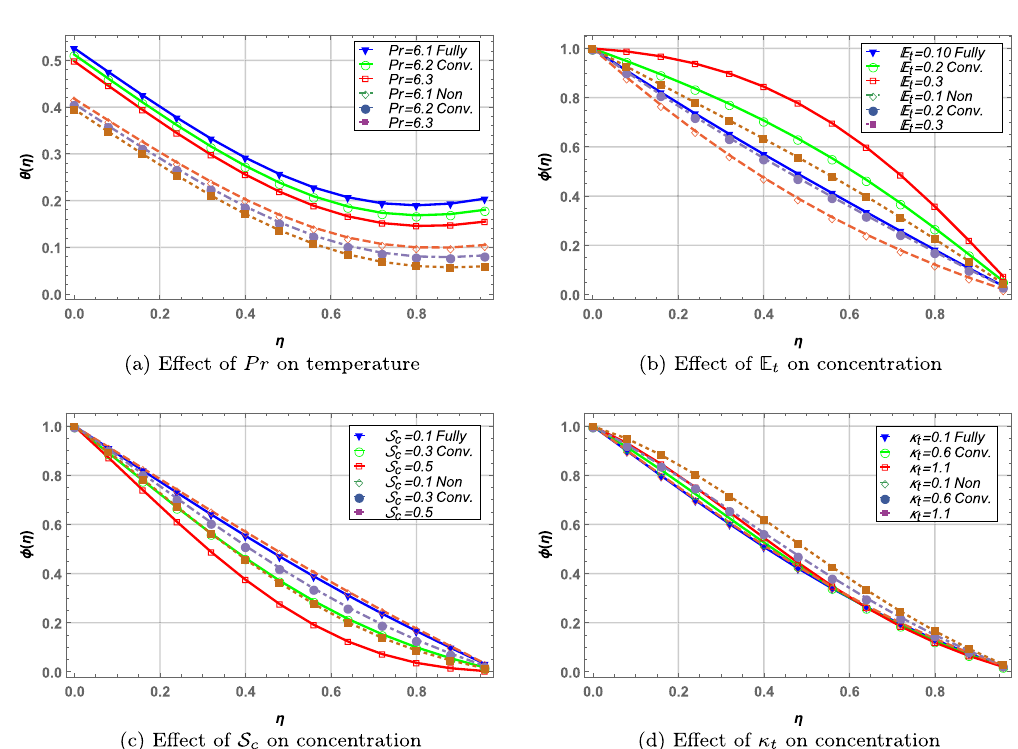
Figure 9. Effect of Prandtl number, activation energy parameter, Schmidt number and chemical reaction parameter on temperature and concentration